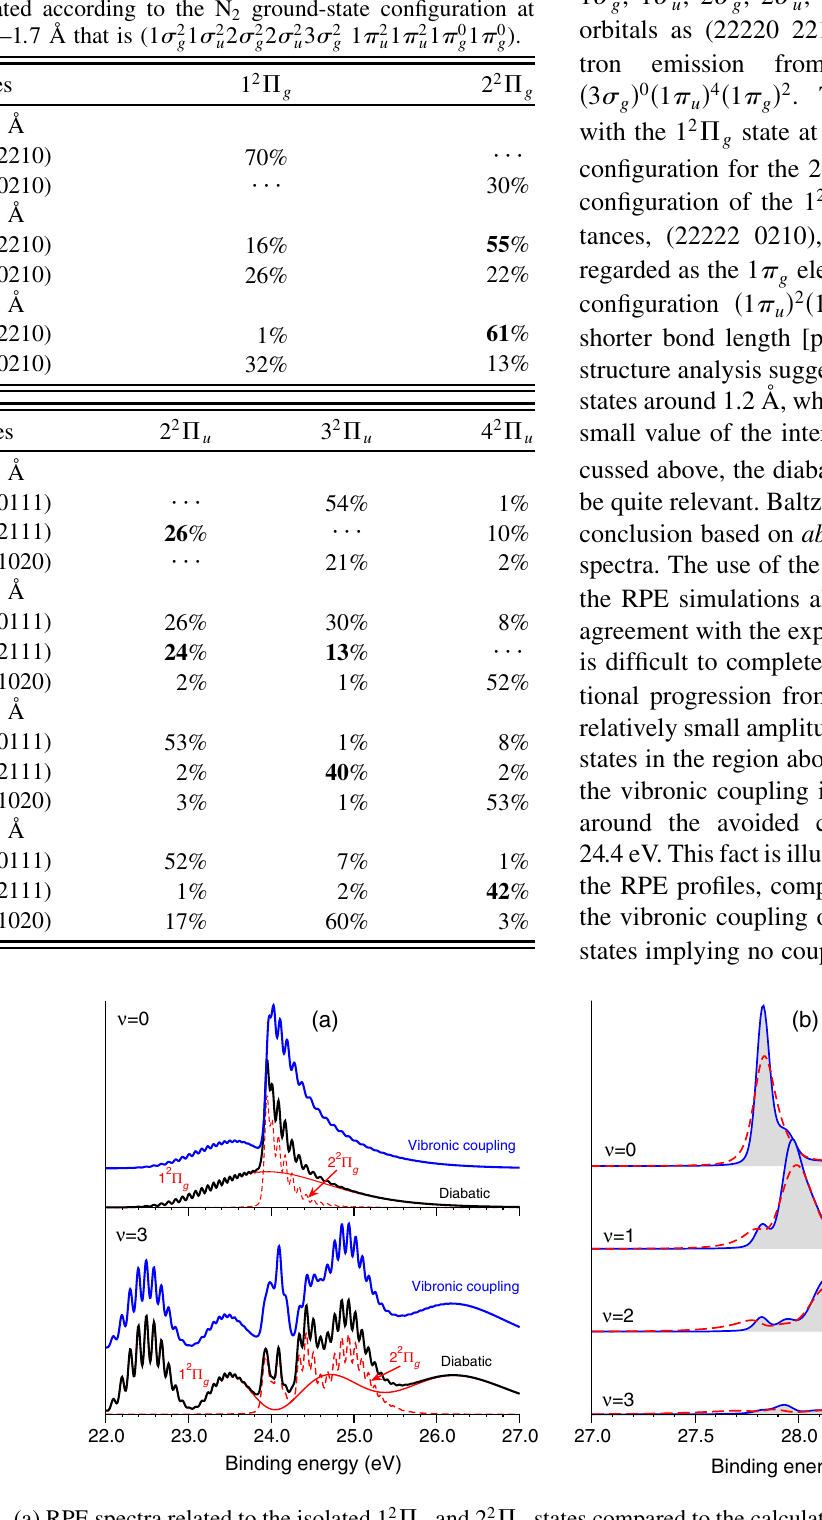
, 3 2 (cid:2) , and 4 2 (cid:2) states u u u